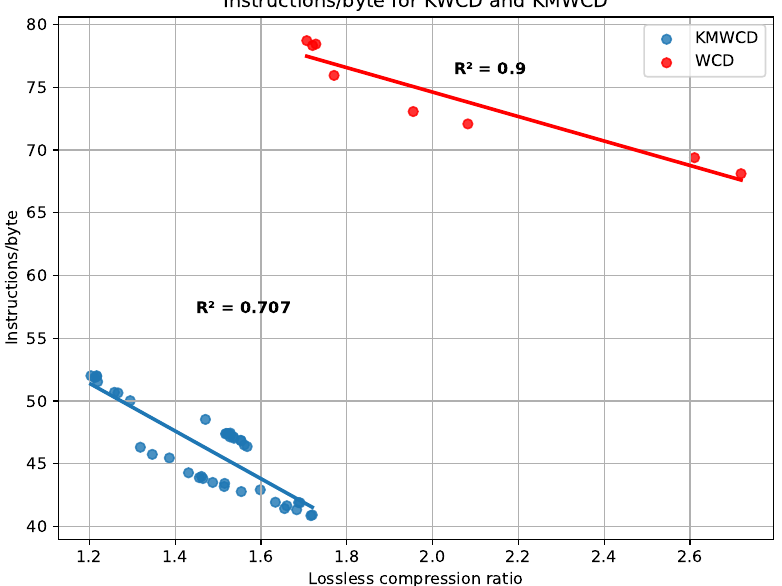
Figure 8. Relationship between ratios and instructions per byte for the KWCD and the KMWCD algorithms. Fugro files not